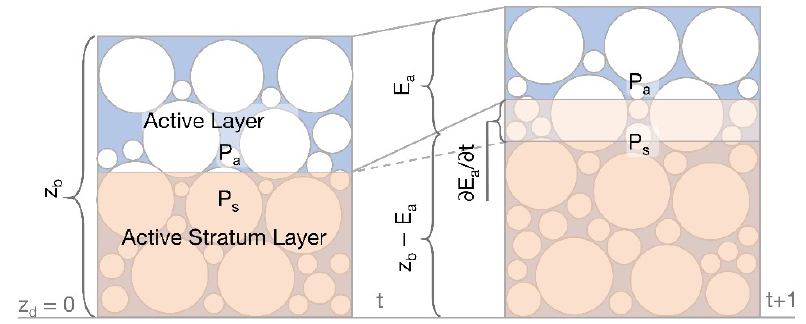
Figure 3. Bed level change due to porosity variation in different time steps.